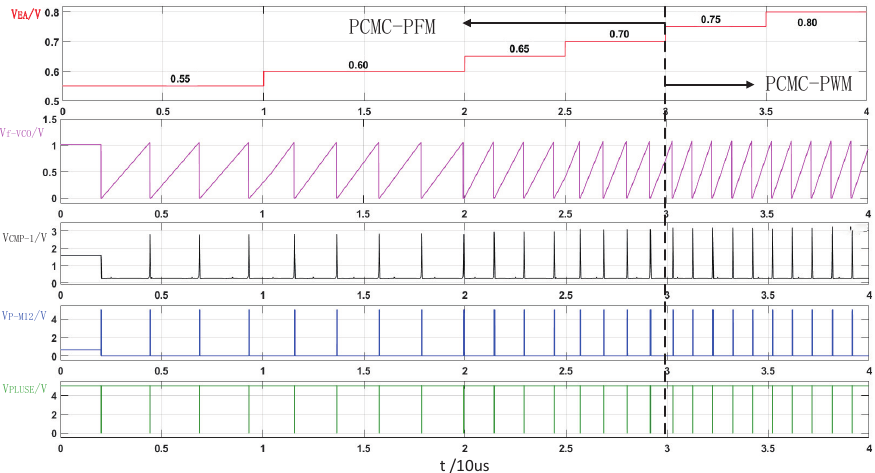
Figure 9. The simulation results of V EA , V ( f − VCO ) , V ( CMP − 1 ) , V ( P − M 12 ) , and V PLUSE